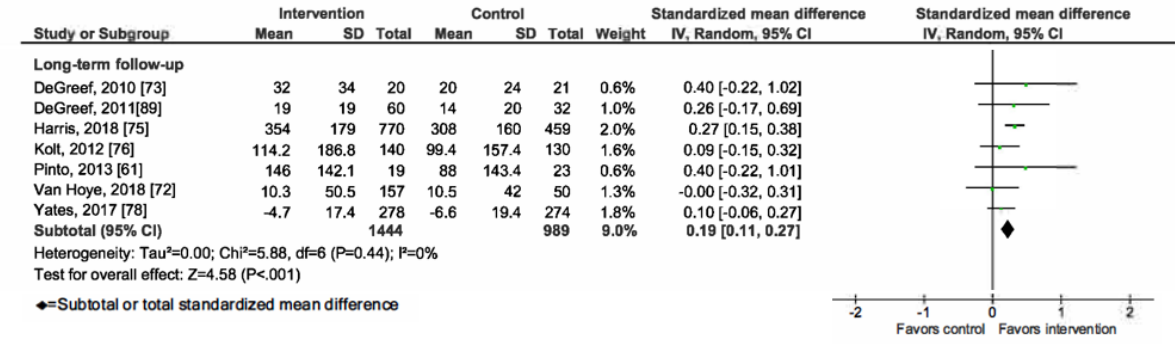
Figure 7. Primary outcome analysis for the outcome moderate-to-vigorous physical activity at timepoint long-term